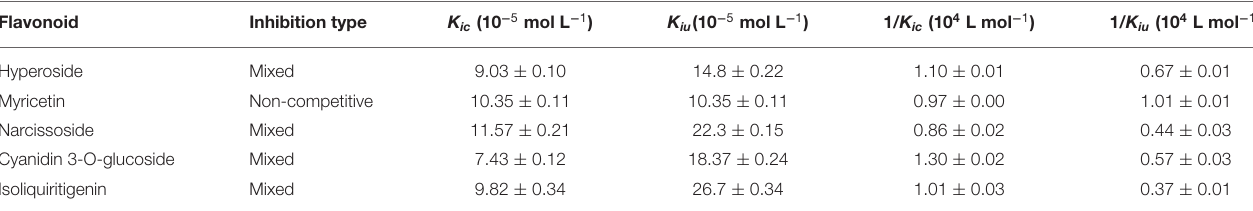
TABLE 2 | Characteristic values of Dixon and Cornish-Bowden plots for the DPP-4 inhibition by hyperoside, myricetin, narcissoside, cyanidin 3-O-glucoside, and isoliquiritigenin.